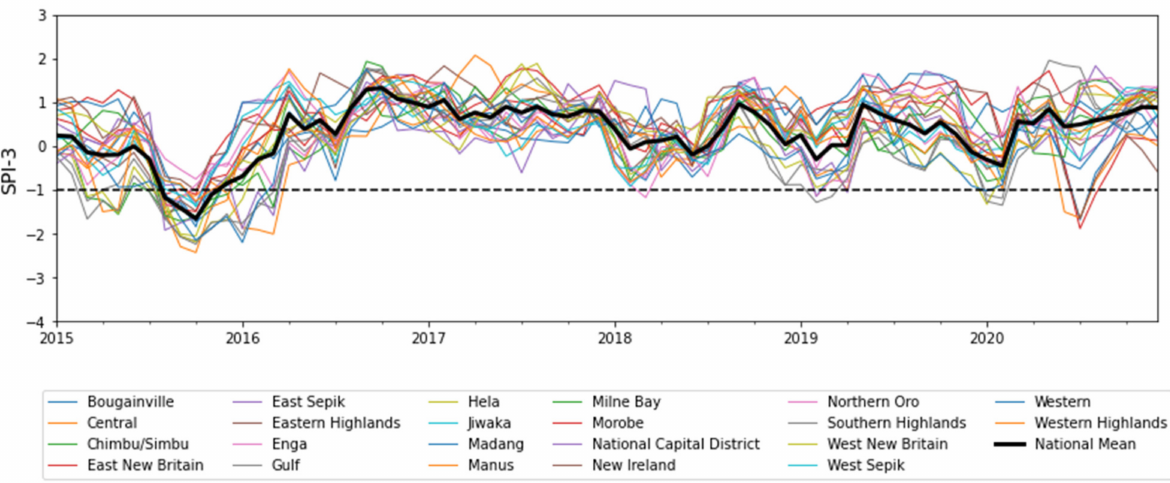
Figure 7. SPI-3 averaged over 22 PNG provinces from 2015 to 2020 and compared to the national mean (in bold